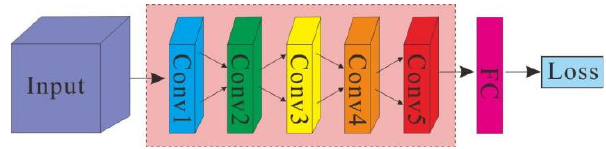
Figure 6. Classification phase model diagram.